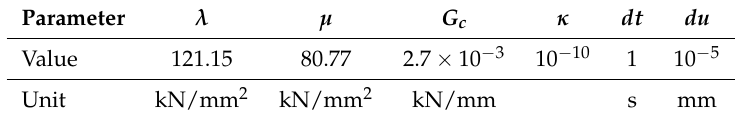
Table 2. Material parameters and configuration for the single-edge notched shear/tension test